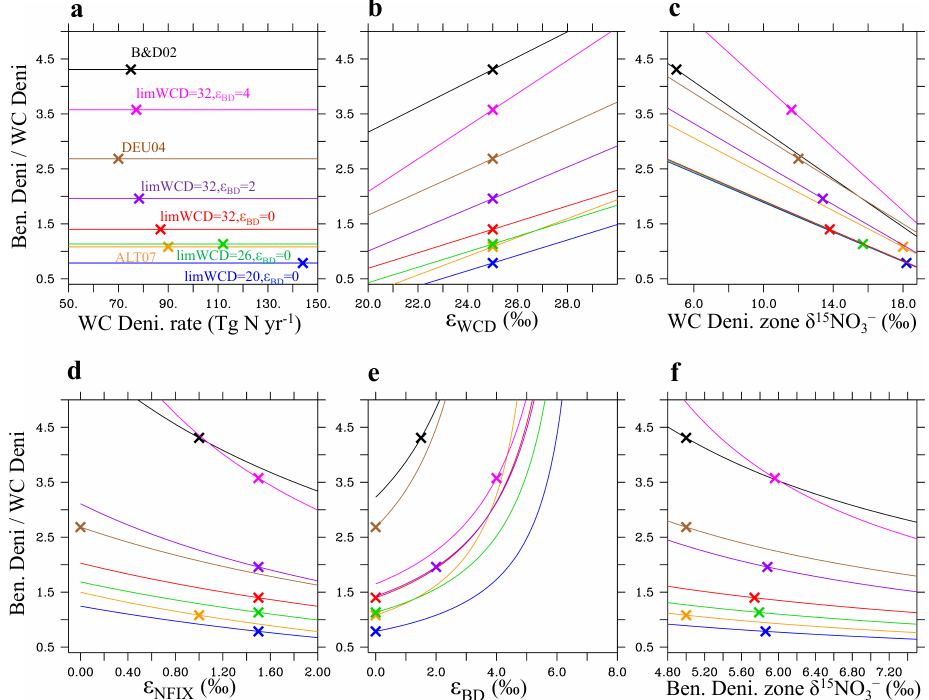
Fig. 6. Results of the one-box δ 15 NO − model with different nitrogen isotope parameter settings according to previous configurations (Bran- 3 des and Devol, 2002; Deutsch et al., 2004; Altabet, 2007) and this study (Table 4). Each panel shows the sensitivity of one parameter on the ratio of benthic denitrification to water column denitrification (BD:WCD) needed to achieve observed global mean δ 15 NO − scenario while all other parameters are held constant: (a) WCD rate, (b) WCD fractionation factor ( ε WCD ) , (c) average δ 15 NO − WCD occurs, (d) N 2 fixation fractionation factor ( ε NFix ) , (e) benthic denitrification fractionation factor ( ε BD ) , and (f) average δ 15 NO − where benthic denitrification occurs. Note ε NFix makes diazotroph biomass depleted in δ 15 N by its associated value. The crosses (X) show the parameter chosen for each reported model configuration and denotes the BD to WCD ratio of the previous studies as well as coupled three-dimensional experiments from this